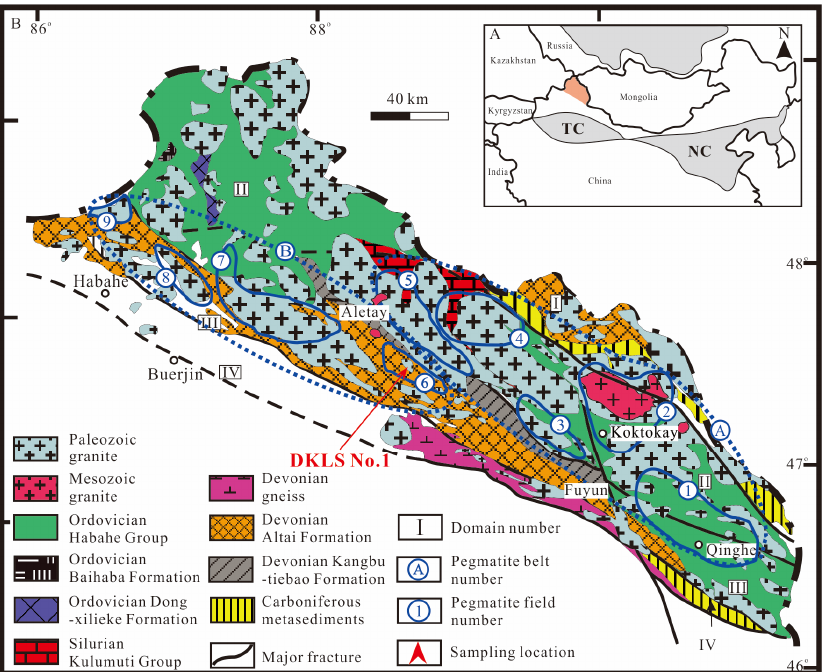
Figure 1. Regional geological map of the Chinese Altay, modified after [35,57,58]. ( A ) Main tectonic units of the Chinese Altay orogen and adjacent areas; ( B ) Geological map of the Chinese Altay, showing the location of mineralized pegmatites and deposits.